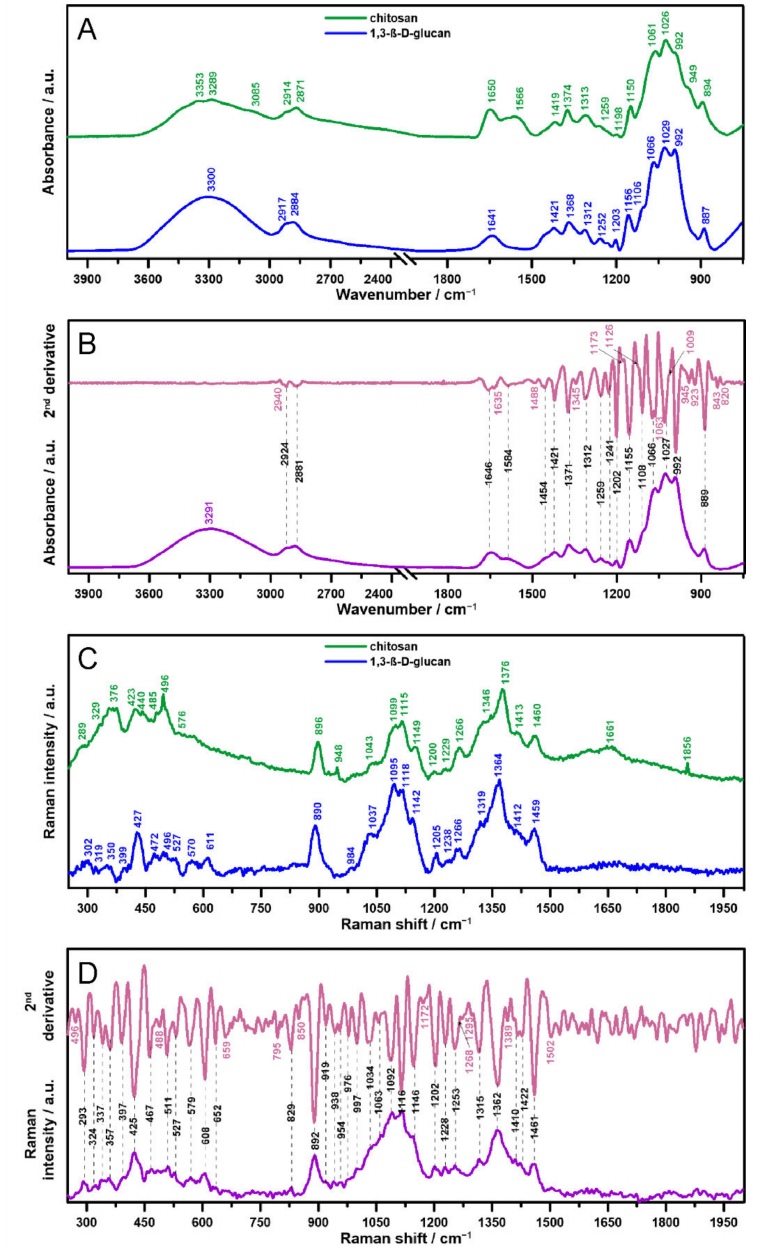
Figure 1. ATR FT-IR ( A , B ) and Raman ( C , D ) spectra of separate components of the polymeric matrix, gelled films of chitosan and 1,3- β - D -glucan ( A , C ); the relative intensity of hybrid chitosan/ 1,3- β - D -glucan spectra along with the second derivatives of the spectra in the entire measured range ( B , D